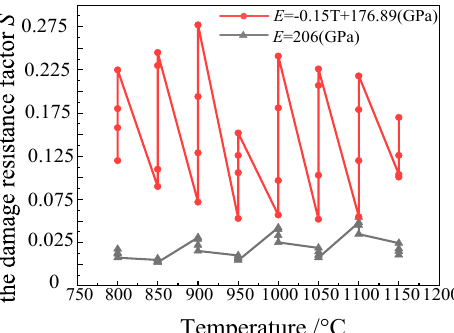
10 of 20 Figure 5. Fitting curve between the E value of the elastic modulus and temperature of the Cr5 al- loy steel. Figure 6 is a comparison diagram of the damage resistance factor S value of the Le- maitre damage model calculated by substituting the elastic modulus (206 GPa, red) of the Cr5 alloy steel at room temperature and the elastic modulus E value measured by the test (black). This figure shows that the damage resistance factor S value directly calculated by the constant elastic modulus of 206 GPa shows little difference at each temperature. Ad- ditionally, at the same temperature, the difference of the damage resistance factor S value under each strain rate is not obvious. However, the S value of the damage resistance factor calculated using the E value measured by the actual elastic modulus measurement test